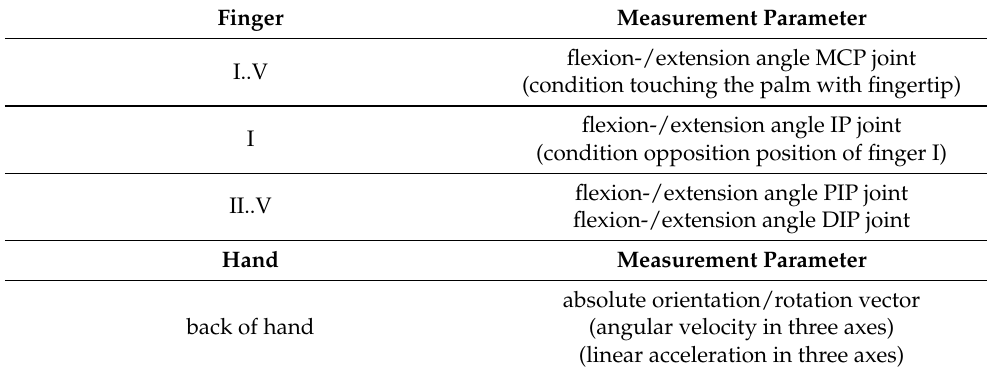
Table 1. Recordable measurement parameter of SenGlove. Fingers numbered I (thumb) to V (pinkie finger). Joints: Distal Interphalangeal (DIP), Interphalangeal (IP), Metacarpophalangeal (MCP), Proximal Interphalangeal